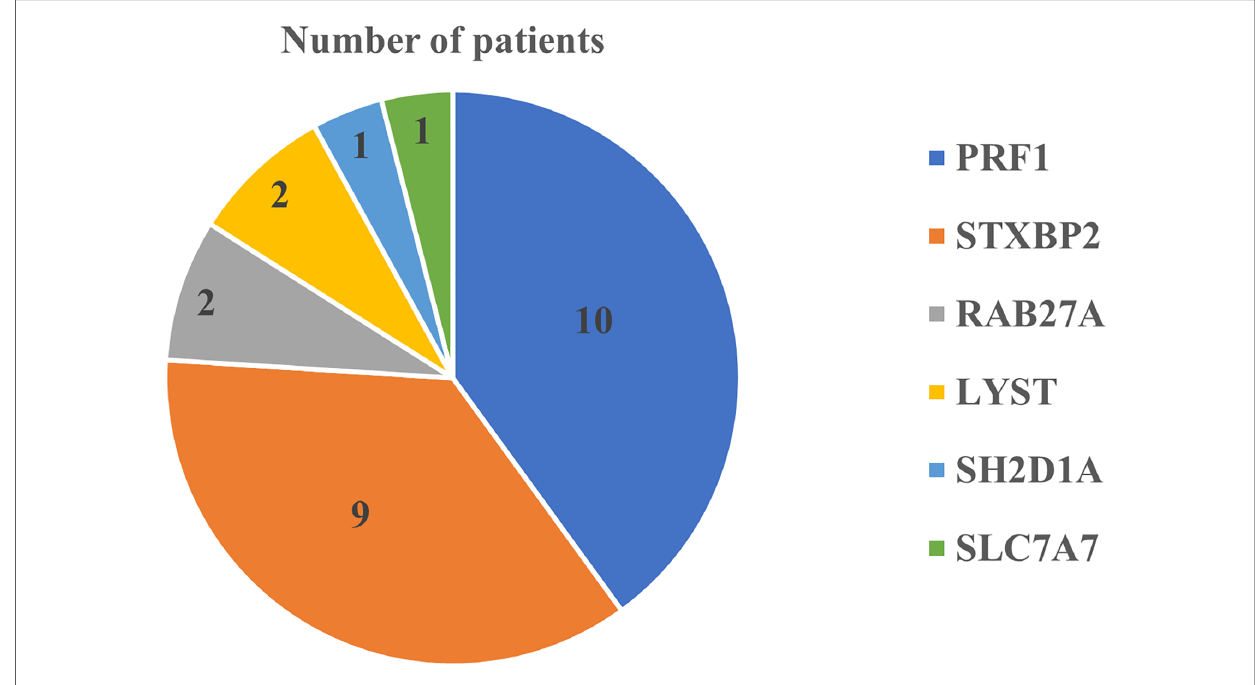
FIGURE 1 Identi fi ed F-HLH genes among studied